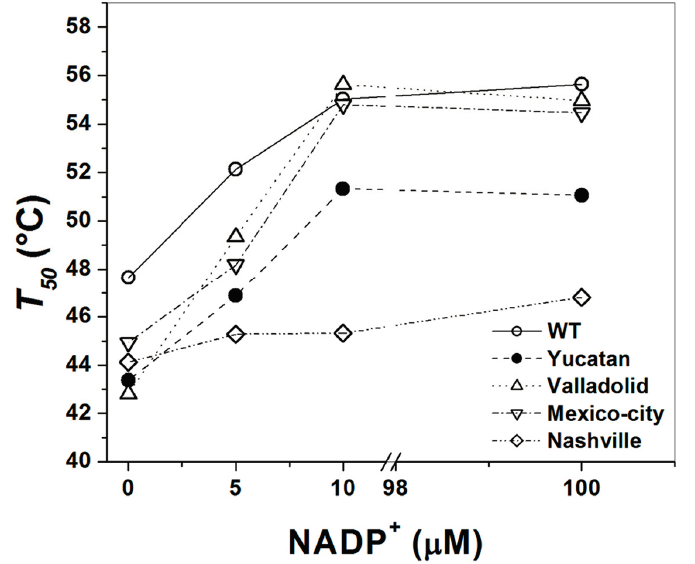
Figure 5. Effect of NADP + on the thermoinactivation of recombinant G6PD enzymes. T 50 is plotted against the NADP + concentration. The WT and mutant enzymes were incubated at different NADP + concentrations. In all cases, 200 ng of total protein was